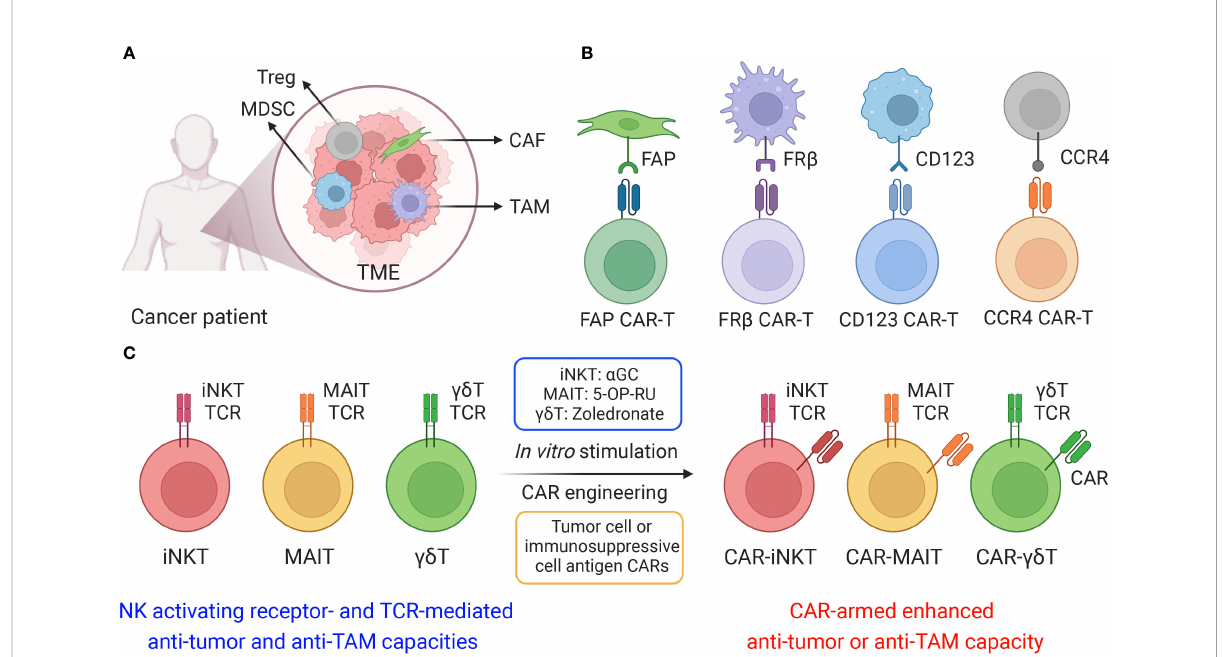
FIGURE 1 Cell-based therapy to target immunosuppressive cells in solid tumor microenvironment (TME). (A) The TME is composed of a heterogeneous milieu of tumor and immune cells. Various immunosuppressive cells such as tumor-associated macrophages (TAMs), myeloid-derived suppressor cells (MDSCs), cancer-associated fi broblasts (CAFs) and T regulatory cells, suppress or reprogram the antitumor immune response. (B) Different chimeric antigen receptors (CARs) were utilized to generate CAR-T cells, including fi broblast activation protein (FAP) CAR, Folate receptor b (FR b ) CAR, CD123 CAR and C-C motif chemokine receptor 4 (CCR4) CAR. (C) Innate T cells, including invariant natural killer T (iNKT) cells, mucosal-associated invariant T (MAIT) cells, and gamma delta T ( gd T) cells, ef fi ciently target immunosuppressive cells, and these innate T cells could be further engineered with CARs and achieve both tumor cell and immunosuppressive cell elimination.